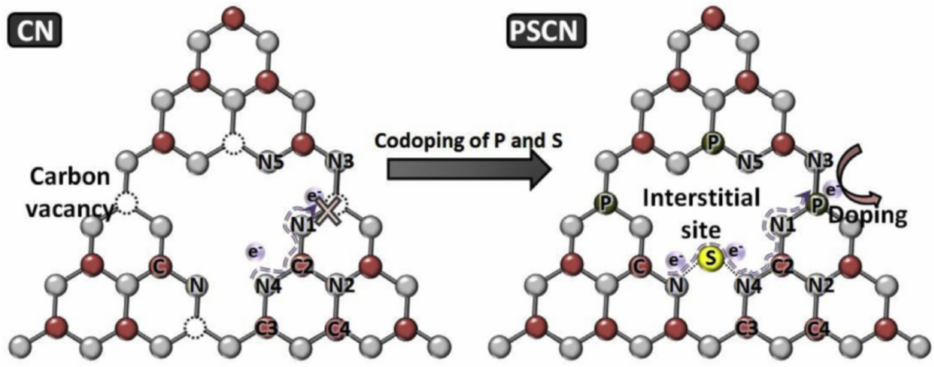
Figure 18. The proposed mechanism of the P, S-GCN charge transfer pathway. Reproduced with permission from Ref.